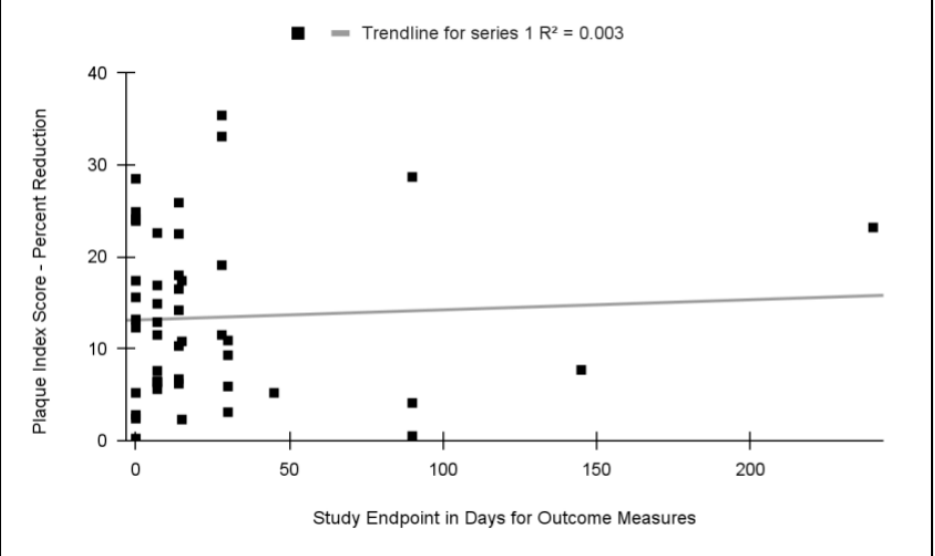
Figure 5. Meta analysis of relative effect (percent reduction in plaque index) plotted against study length (endpoint measures). No significant association was found between these variables with a coefficient of determination, R 2 = 0.003. Studies lasting 0 days exhibited similar average plaque reduction effects (14.2%) as those lasting 7 to 14 days (13.8%), p = 0.711, or 30 days and longer (14.1%), p =